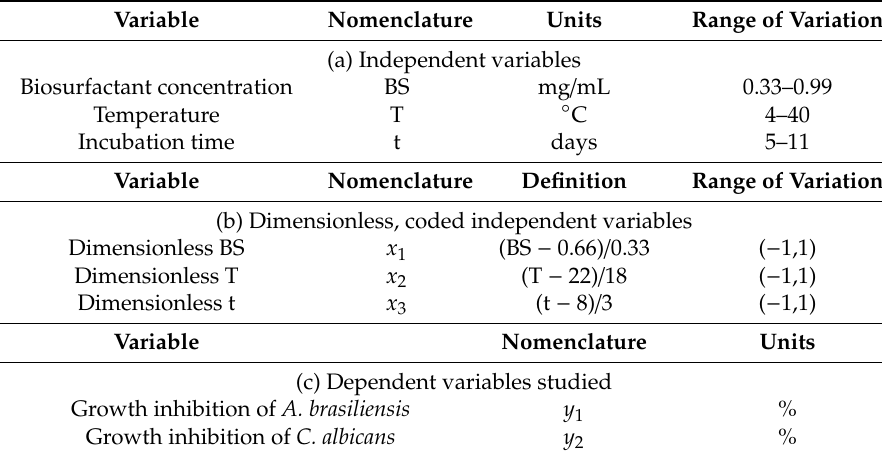
Table 1. Independent and dependent variables used in the